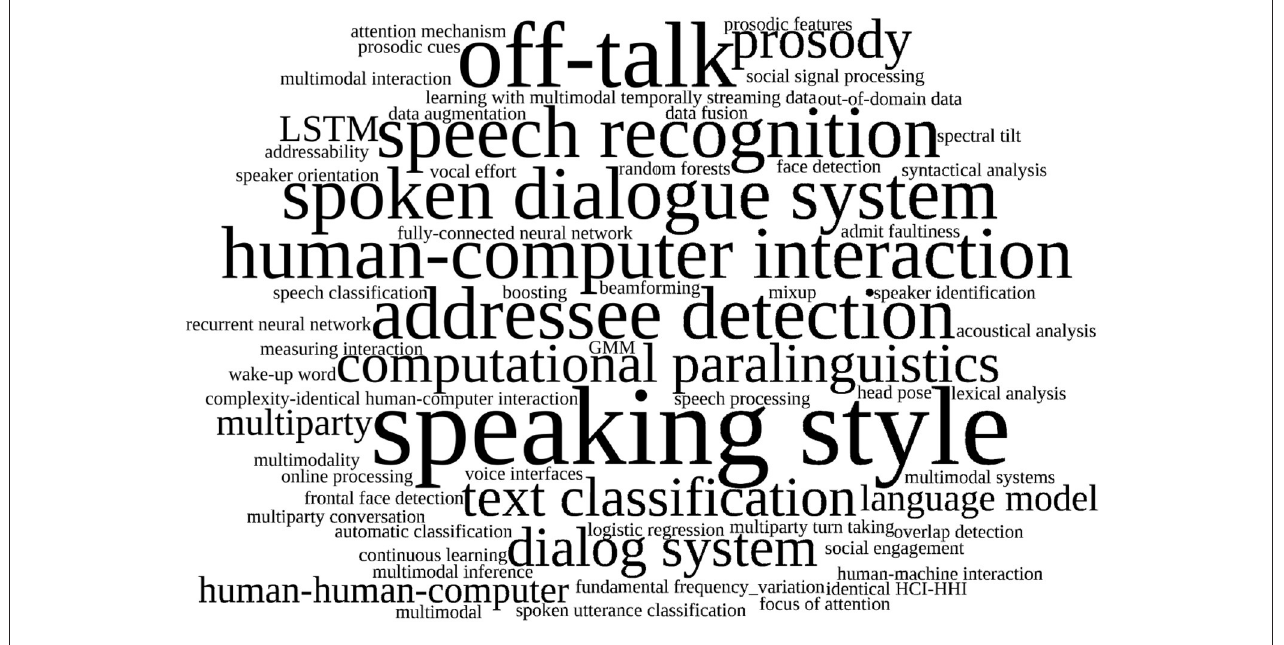
FIGURE 2 | Word clouds as illustration of the used author keywords in the identified studies.